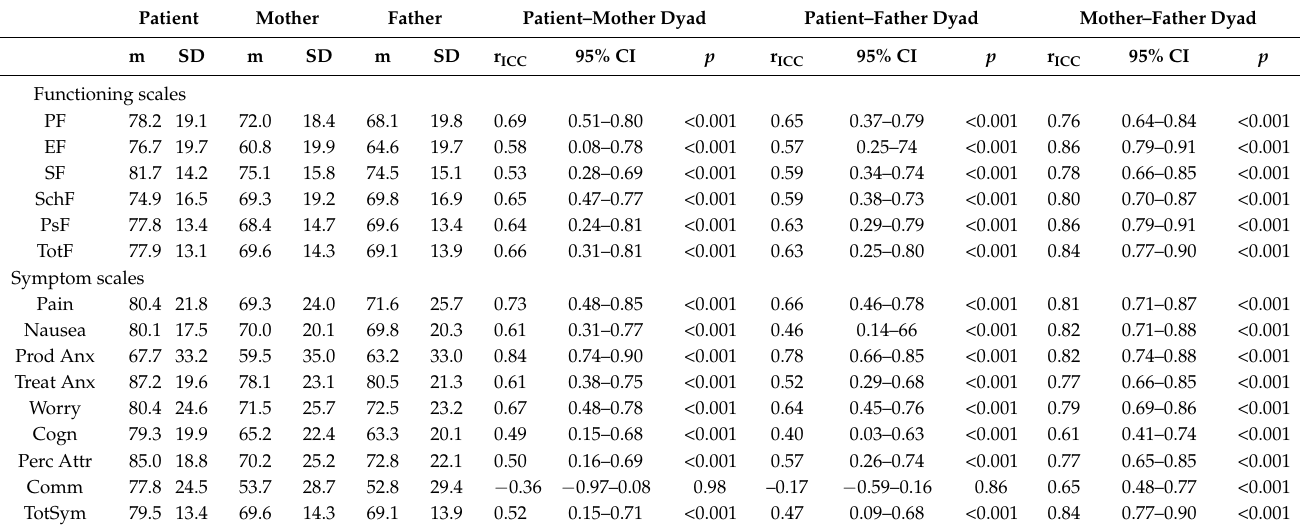
Table 5. Associations of the children’s self-report and parental proxy ratings before rehabilitation (t0), stratified by patient–mother and patient–father